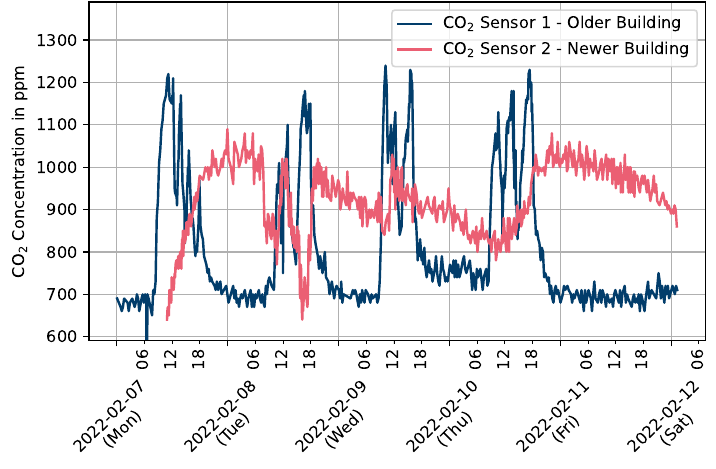
Figure 11. Comparison of CO 2 concentrations in two rooms in different buildings